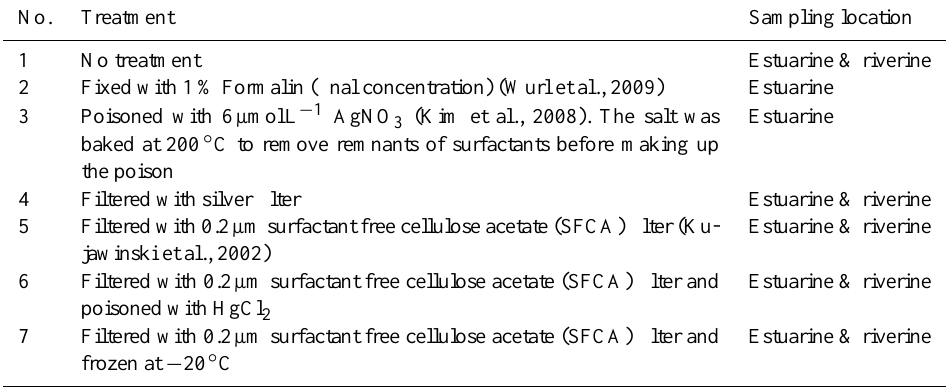
Estuarine Estuarine &